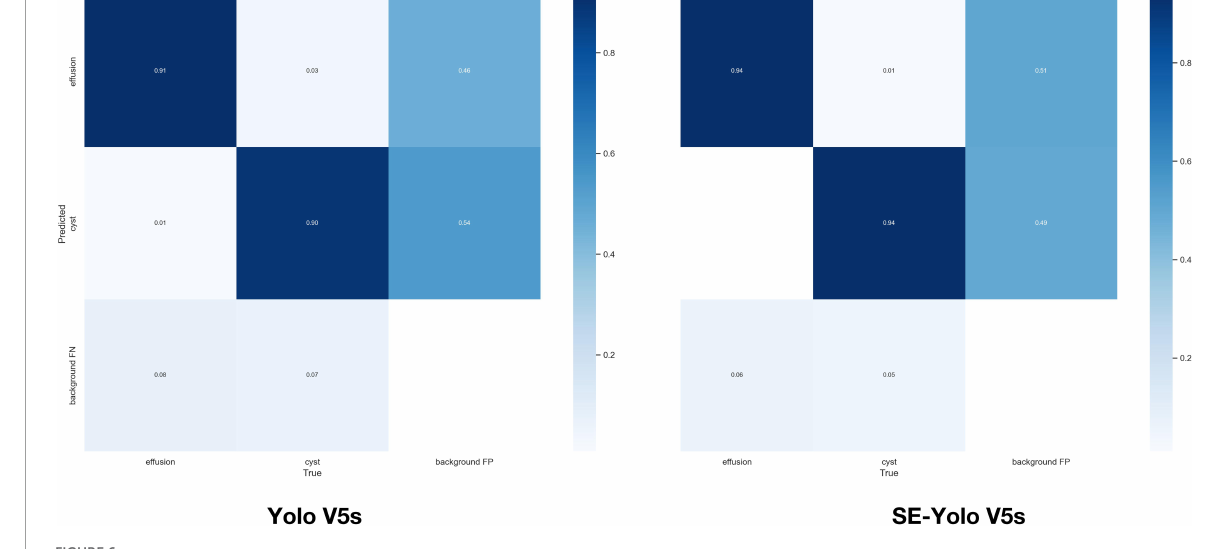
FIGURE6 Confusion matrices of YOLO V5 and YOLO V5-SE.